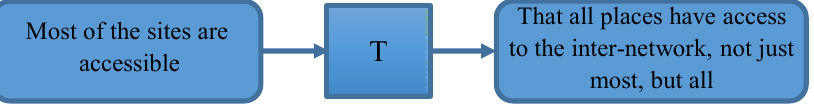
Fig. 2. Transformation and benefits of the Internet in higher education